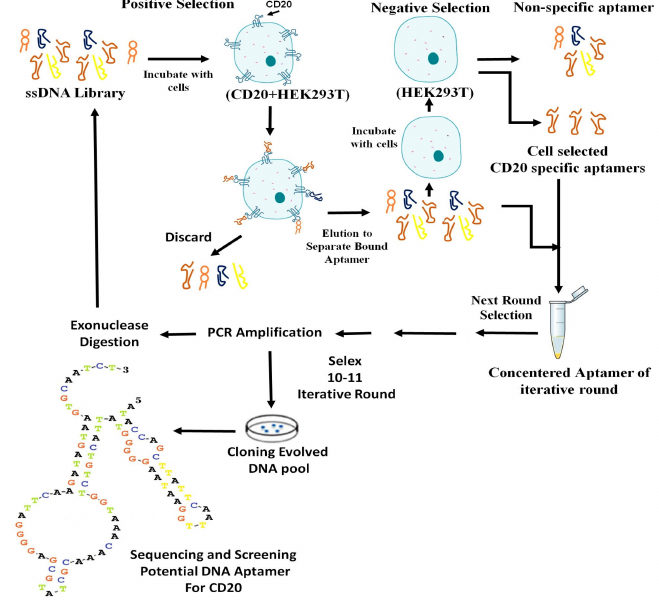
Scheme 1. The steps of Cell-SELEX are depicted in the above schematic